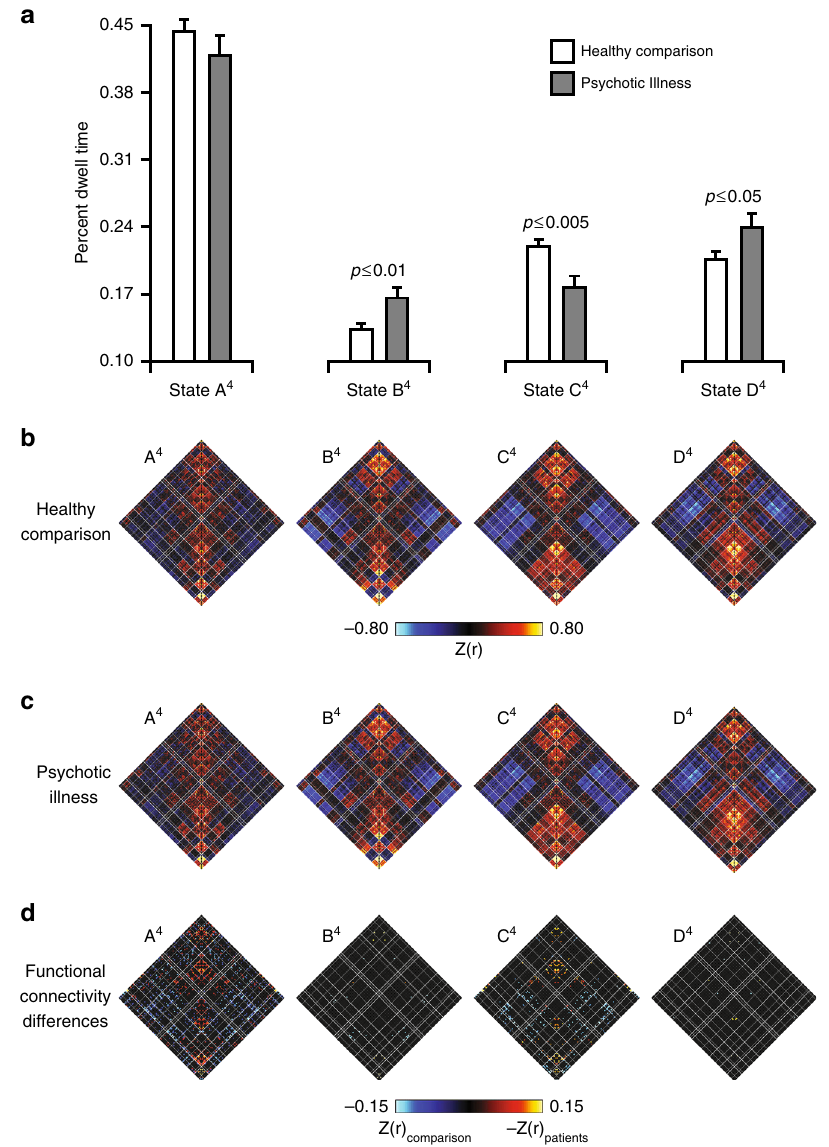
Fig. 6 Psychotic illness links to state-speci fi c reductions in connectivity. a Bar graphs display the percent of time healthy comparison participants and individuals with psychotic illness dwell in each state of the four-state solution. b – c The 2D grids ( b – c ) display the complete coupling architecture of the cerebral cortex measured at rest for each group of participants. d Differences were obtained by an analysis of variance of z-transformed Pearson correlation values after linear regression of the effects of age, sex, race, ethnicity, and handedness [r(z) Comparison – r(Z) Patient group ]. The bottom panel shows signi fi cant group differences at false-discovery rate q ≤